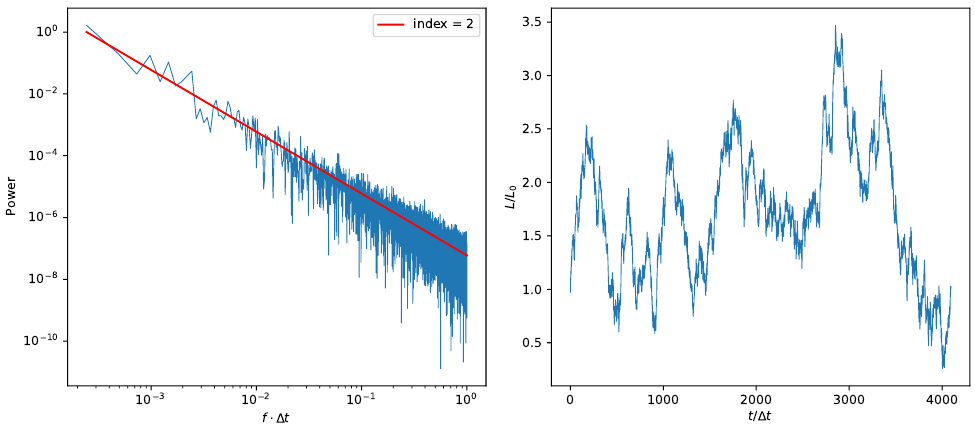
Figure 2. ( Left ) Typical generated stochastic PSD for a power law spectrum with index α = 2.0. ( Right ) Variation recovered from stochastic PSD by FFT and adapted to represent injection luminosity. Light curves produced by the leptonic model for the given variation were analysed. PSDs were calculated by FFT to be compared to the input variation PSD and different variations. Cross-correlations between light curves of different frequencies were also calculated to probe correlations and possible time lags between the variability in different energy